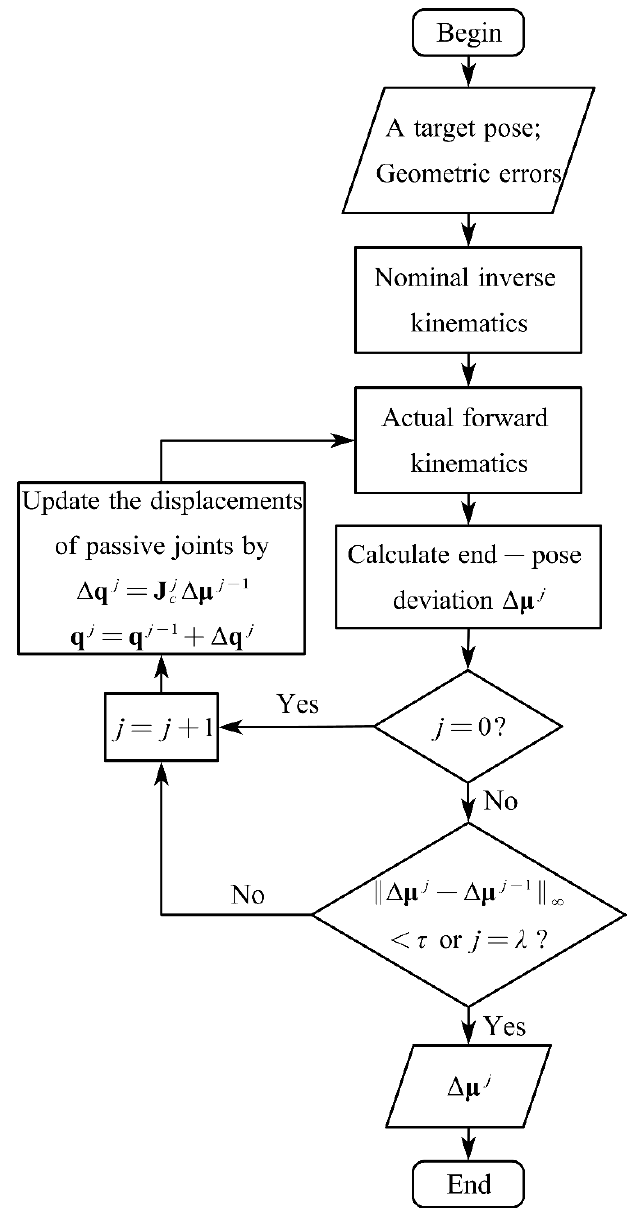
Figure 3. Scheme I: Evaluation of the limbs’ comprehensive deformations caused by geometric errors Figure 3. Scheme Ⅰ : Evaluation of the limbs’ comprehensive deformations caused by geometric er- of the 2UPR-RPU over-constrained rors of the 2UPR-RPU over-constrained manipulator.